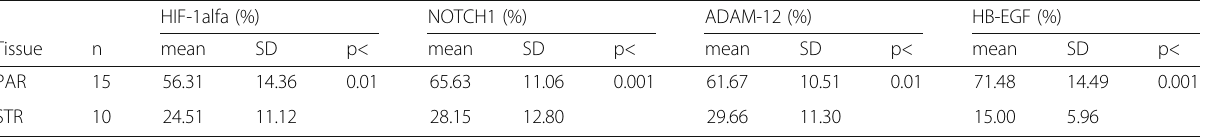
Table 3 The p values when comparing HIF-1 α , NOTCH1, ADAM-12, and HB-EGF expression among parenchyma and stroma, Kruskal – Wallis test